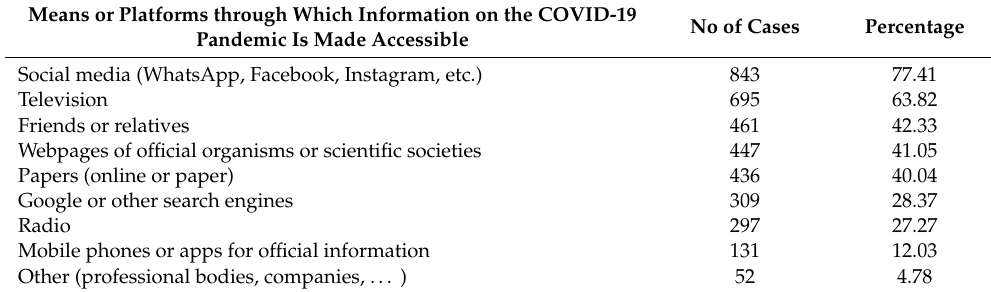
Table 4. Means or platforms through which information on the COVID-19 pandemic is made accessible for non-health